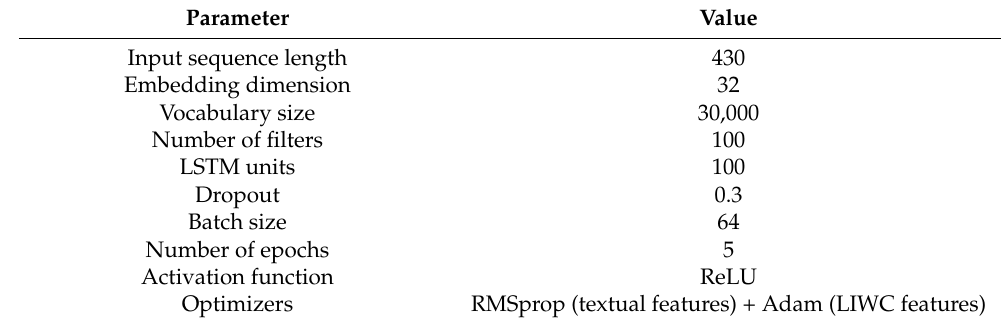
Table 1. Parameters and their values used in the CNN–BiLSTM